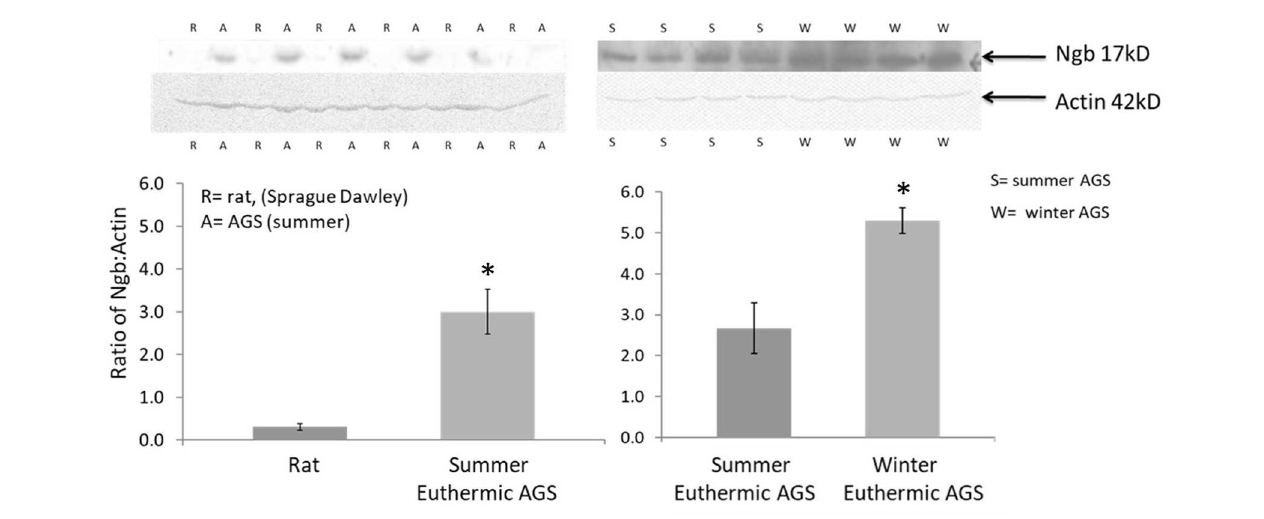
FIGURE7 Western blots show higher expression of the 17kD neuroglobin monomer in cortex of AGS compared to cerebral ischemia sensitive rat and in cortex of euthermic AGS in winter compared to euthermic AGS in summer; 100 µ g of protein was resolved on 10% SDS-PAGE and membranes were incubated with anti-Ngb (Ngb PolyAntibody (FL-151), 1:200, Santa Cruz Biotechnology, sc-30144) overnight followed by incubation with HRP-conjugated secondary antibody (Gt anti-rabbit IgG, 1:5,000, Santa Cruz Biotechnology). Optical density was normalized to actin. Rats were male, 3–4 months. AGS were male and female, adult ( > 1 year of age). * P < 0.0003, t -test, n = 6 AGS vs rat; * p < 0.0045, t -test, n = 4 summer vs. winter euthermic AGS [adapted from Bhowmick